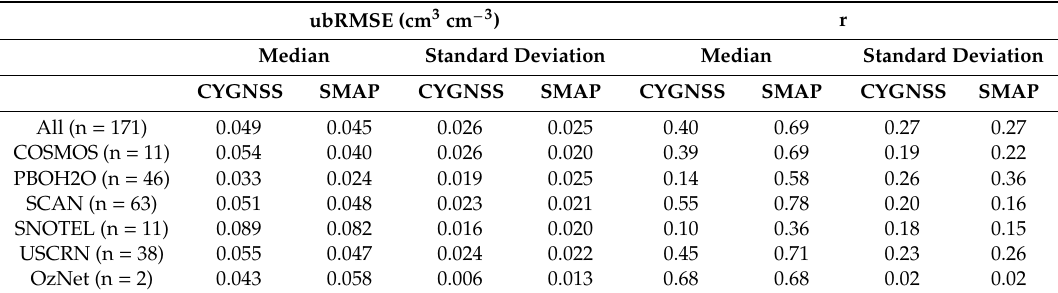
Table 1. Median unbiased root-mean-square error (ubRMSE) and correlation coe ffi cient (r) between CYGNSS and in-situ soil moisture sites, with those from SMAP shown for context. ubRMSE and r values were calculated for the time period between 2 October 2018, and 31 December 2019, unless an individual station did not have data for the full time period. Note that the distribution of r values for SMAP is significantly non-normal, which limits the interpretation of the standard